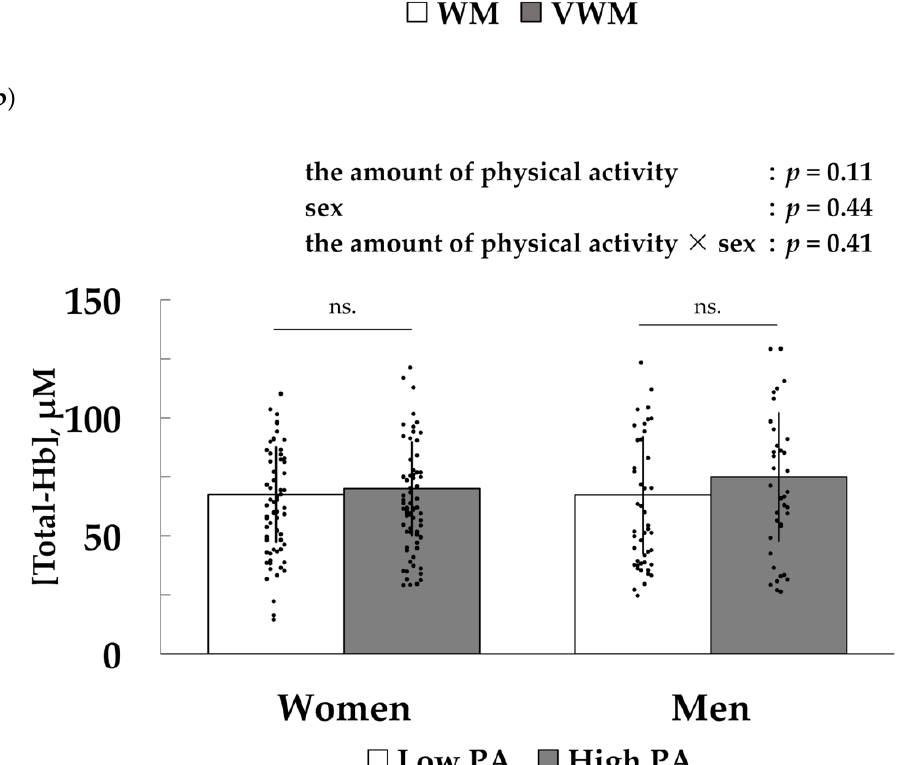
Figure 2. Comparison of [Total-Hb] in the supraclavicular region, an index of brown adipose tissue density ( a ) between a group performing all physical activities including walking, moderate physical activity, and vigorous-intensity physical activity (VWM) and a group performing physical activities including walking and moderate physical activity (WM); ( b ) between the higher physical activity (High PA) group and the lower physical activity (Low PA) group. Results are presented as the mean ± standard deviation. Two-way analysis of variance was performed to determine the significance of group and gender differences; ns., not significant.